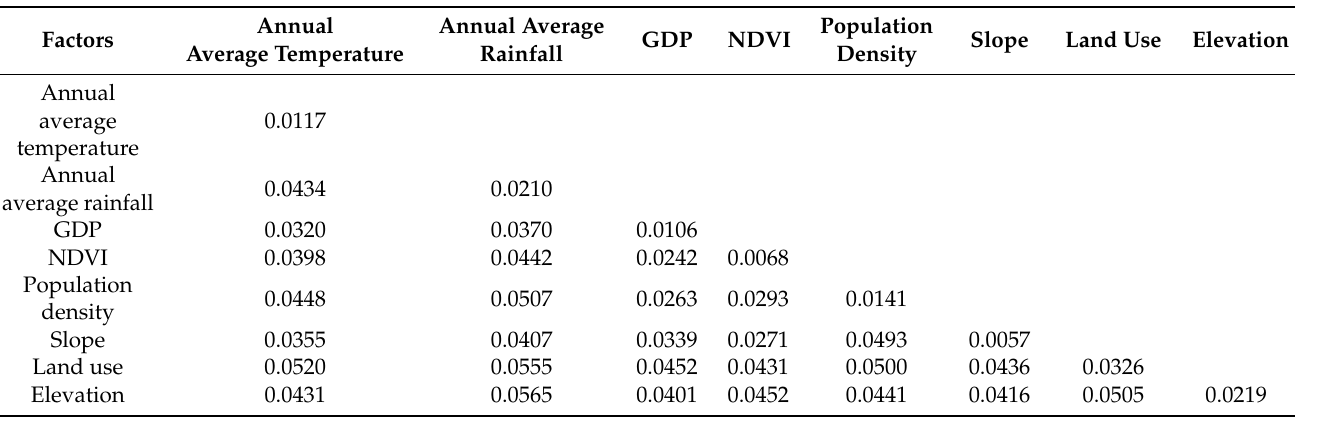
Table 7. Interactive detection of habitat